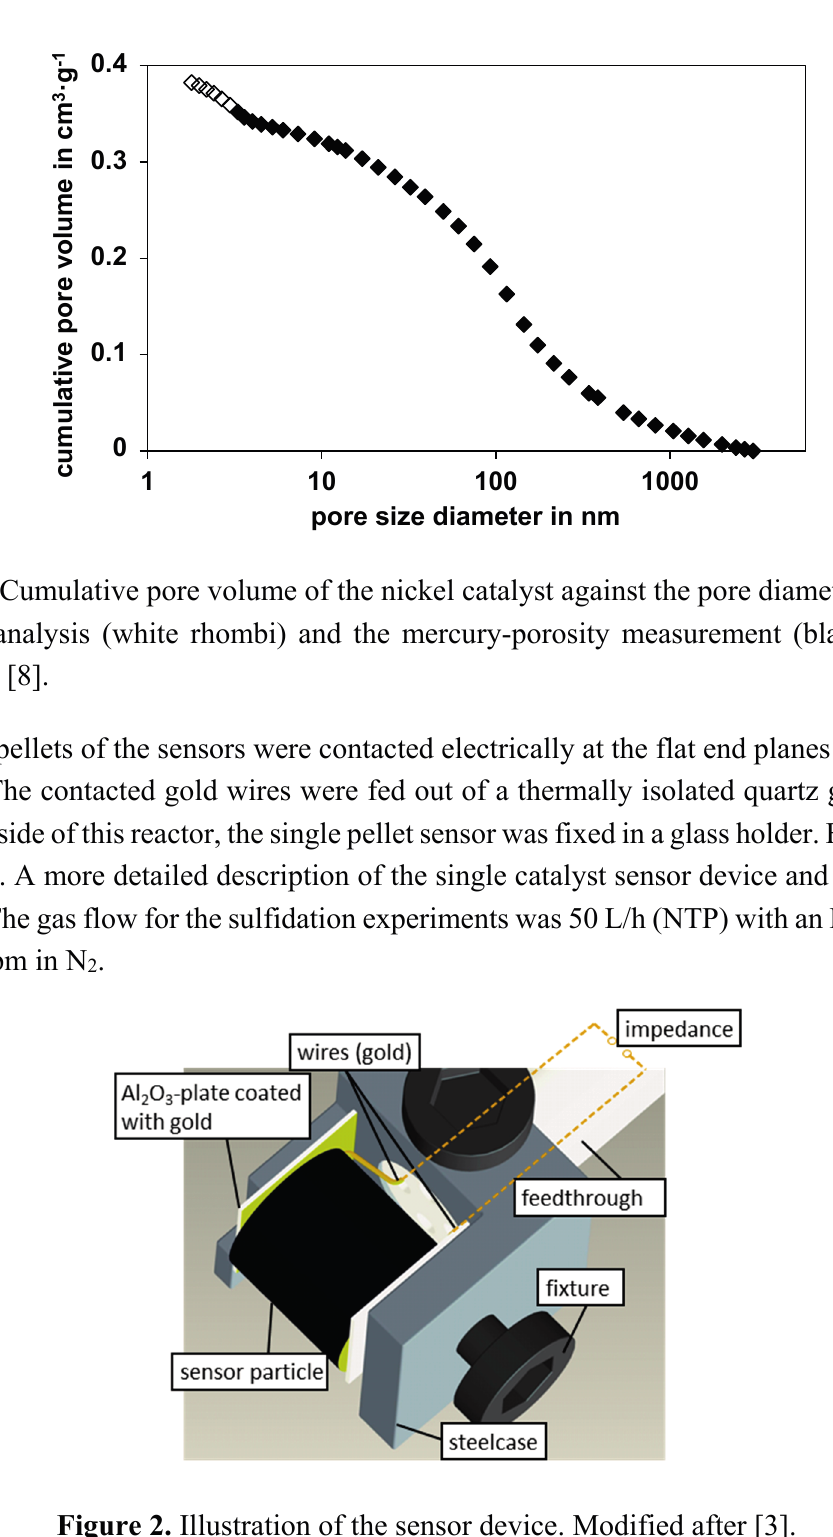
Figure 2. Illustration of the sensor device. Modified after